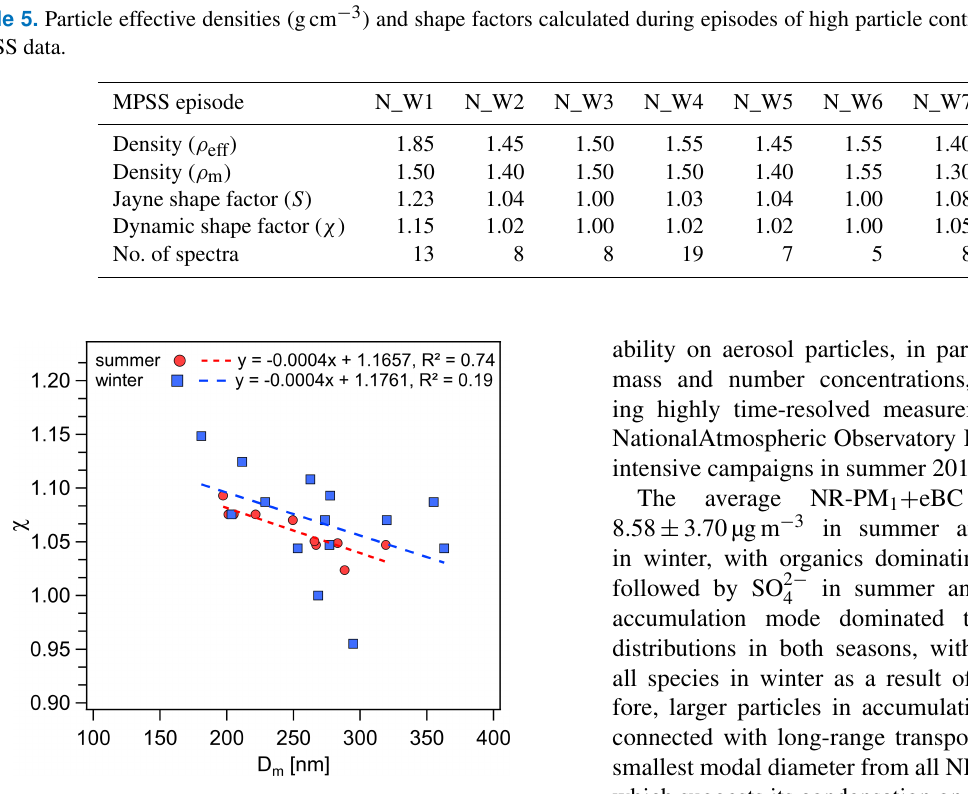
Figure 9. Calculated variation of the mobility diameter ( D m ) as a function of the dynamic shape factor ( χ ) for the summer and winter episodes of high mass